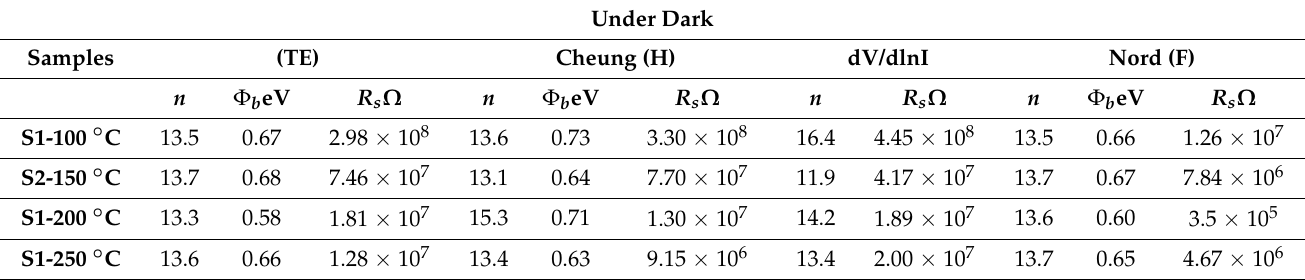
Figure 8. Plots of dV/dlnI vs. I of MoO 3 /Si heterostructure photodetector under dark illumination for different thicknesses. Table 2. The ideality factor, barrier height, and series resistance of MoO 3 /Si in the dark were determined through various methods at different preparation temperatures. Under